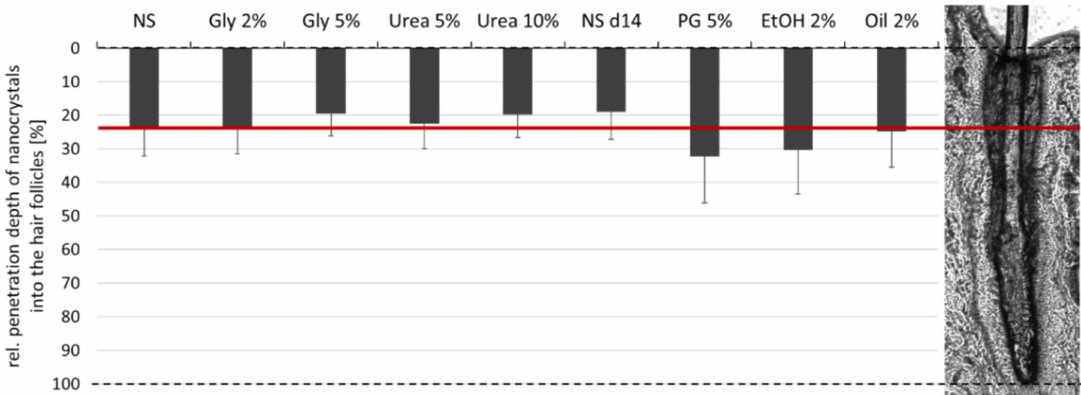
Figure 11. Relative penetration depth [%] of curcumin nanocrystals into the hair follicles from formulations containing di ff erent types and amounts of excipients. The relative penetration depth was calculated from the determined mean penetration depth obtained from each formulation and was related to the mean lengths of the hair follicles (porcine ear—ventral side) that was determined to be 1222 µ